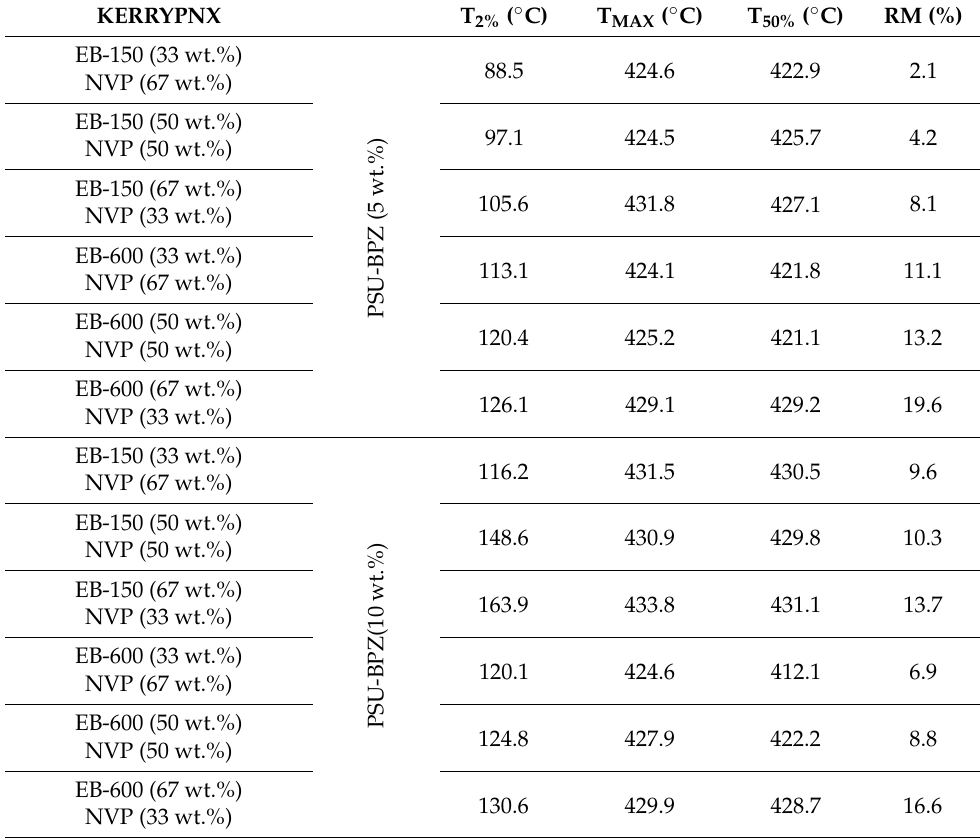
Table 5. Data of thermogravimetric measurements of the blends containing of PSU-BPZ.